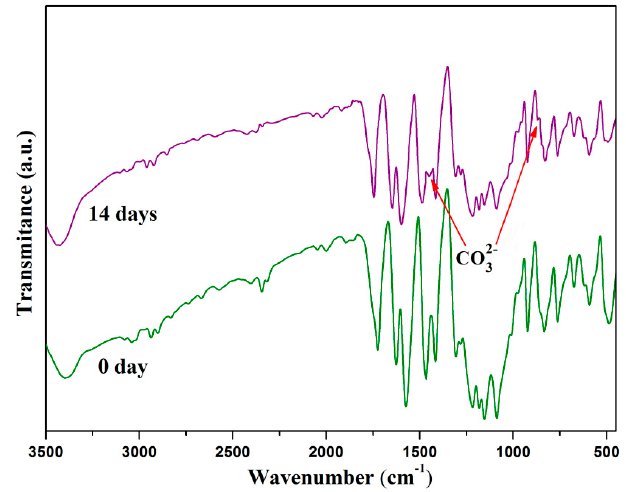
Figure 7. Fourier transform infrared spectrums of the scaffolds with 10 wt % HAP before and after immersing in SBF.